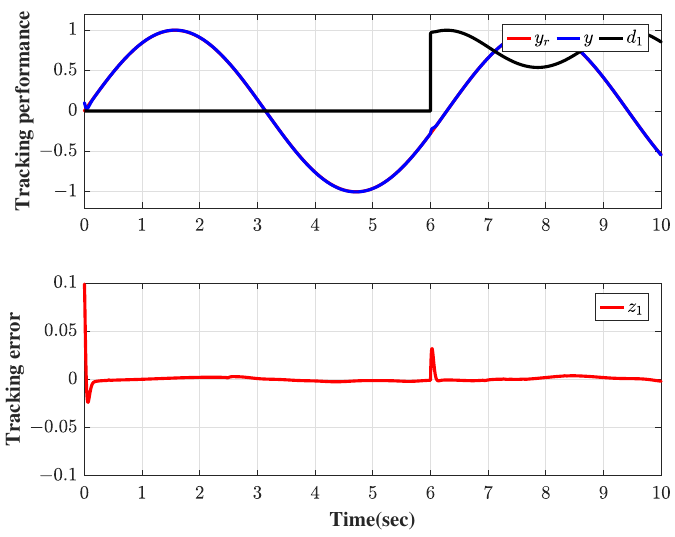
Figure 8. Tracking performance and tracking